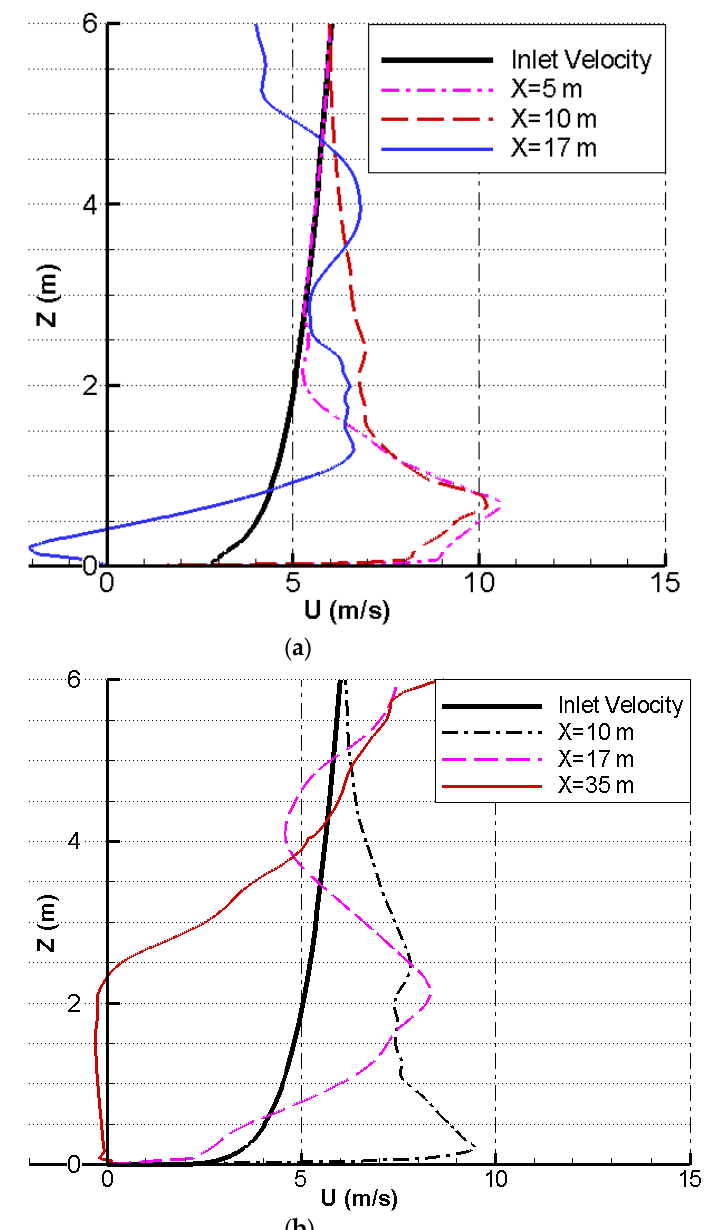
Figure 4. Vertical profiles of longitudinal velocity at different longitudinal positions (U ref = 6 m/s, t=20 s) aligned with the ( a ) midplane Y = 0 ( b ) section plane at Y = 9 m.